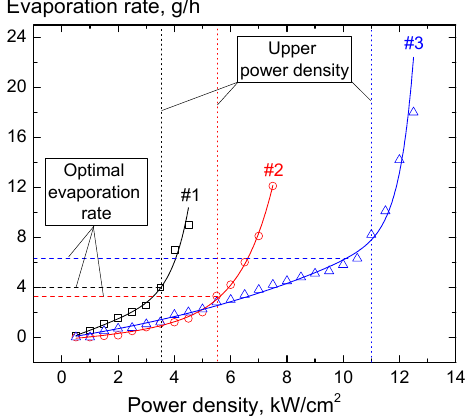
Figure 24. Evaporation rate during electron-beam evaporation of the target of a type of alumina ceramics vs. the electron-beam power density. Beam current up to 200 mA; pressure 10 Pa, beam diameter 5 mm.